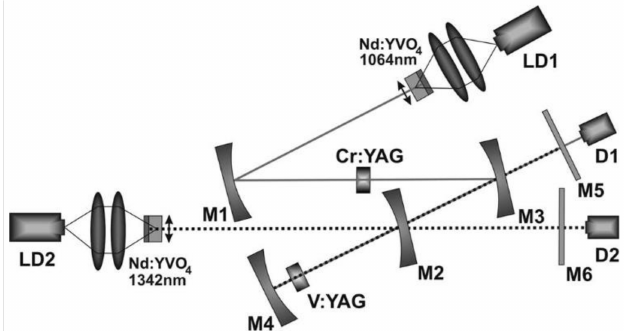
Figure 2. Setup for passively synchronized Q-switched Nd:YVO 4 lasers oscillating at 1064 and 1342 nm